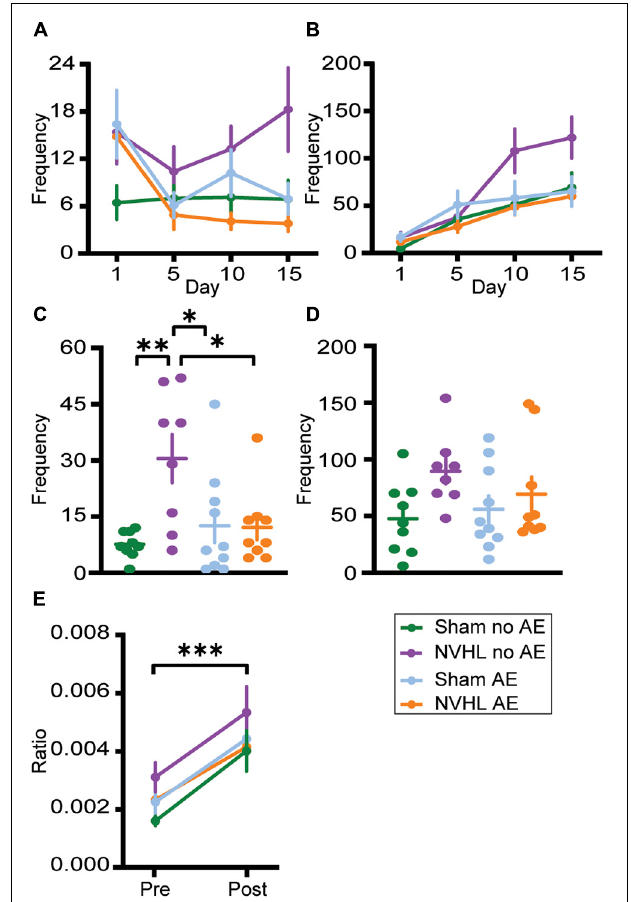
FIGURE 6 | Center zone frequency. (A) Frequency of center zone crosses before the injection of nicotine on days 1, 5, 10, and 15. (B) Frequency of center zone crosses after the injection of nicotine on days 1, 5, 10, and 15. No significant group differences were observed. (C) NVHL no AE rats had significantly increased frequency of center crosses during preinjection on the challenge day. (D) Following the nicotine injection on challenge day, no group differences were observed. (E) There was a significant increase in the ratio of frequency of center crosses to distance traveled following nicotine on the challenge day with no group differences. Data is shown as group mean ± SEM. ∗ p ≤ 0.05; ∗∗ p ≤ 0.01; and ∗∗∗ p ≤